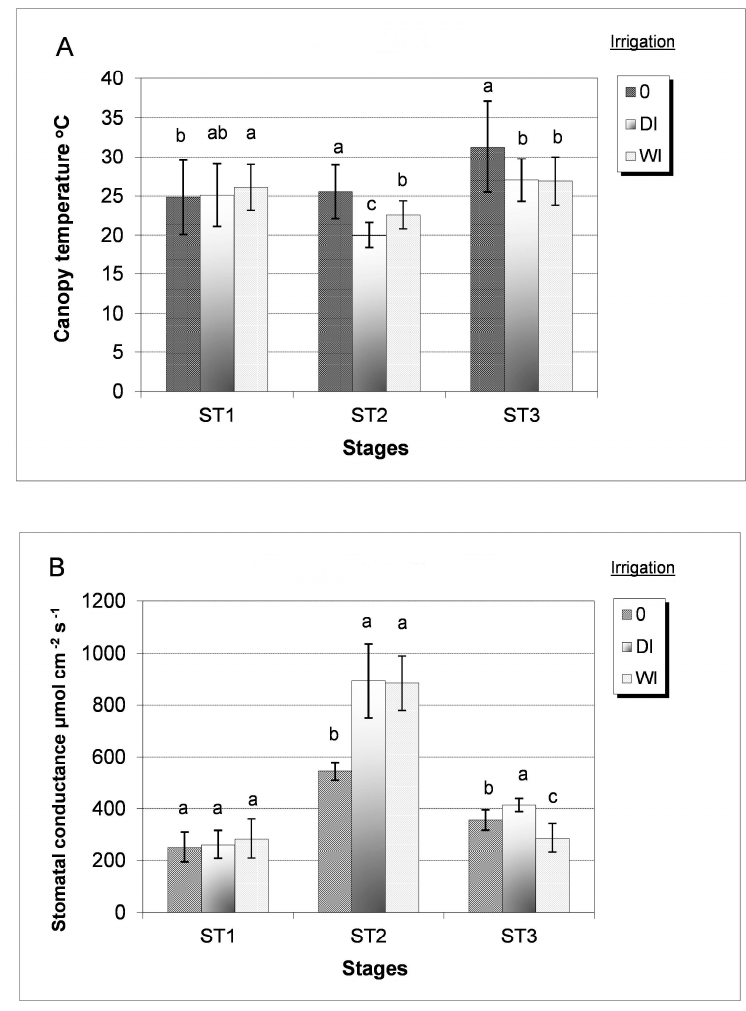
Figure 2. Effect of water supply conditions on canopy temperature ( A ) and stomatal conductance ( B ) during the growth stages (ST1 at beginning of flowering, ST2 during flowering with fruit development, ST3 during early fruit development) under non-irrigation (I0), deficit irrigation (DI), and regular irrigation (WI). Data presents the average of years 2011 and 2015 ± SD. Means followed by different letters are significantly different at p < 0.05 using Duncan’s multiple range test.